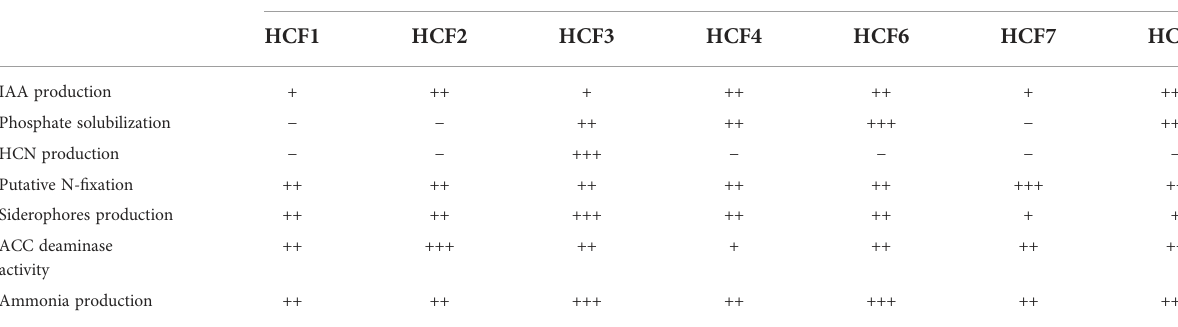
TABLE 2 In vitro plant growth promoting (PGP) traits of seven bacterial endophytes. PGP